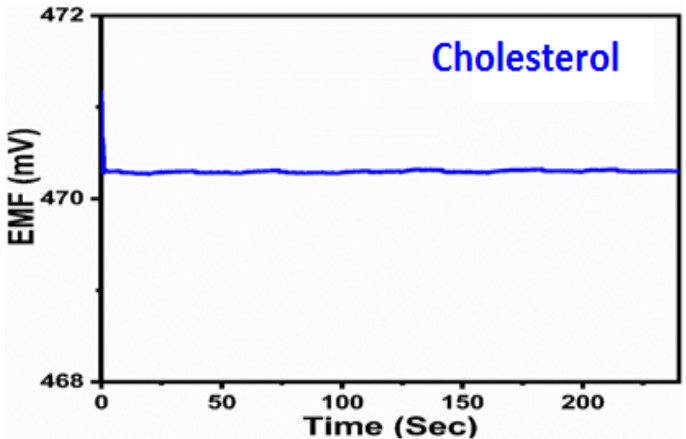
Figure 8. Dynamic response investigation of cholesterol oxidase-immobilized Co 3 O 4 nanocrystals in 10 mM phosphate buffer solution of pH 7.3 in 0.5 mM cholesterol concentration.